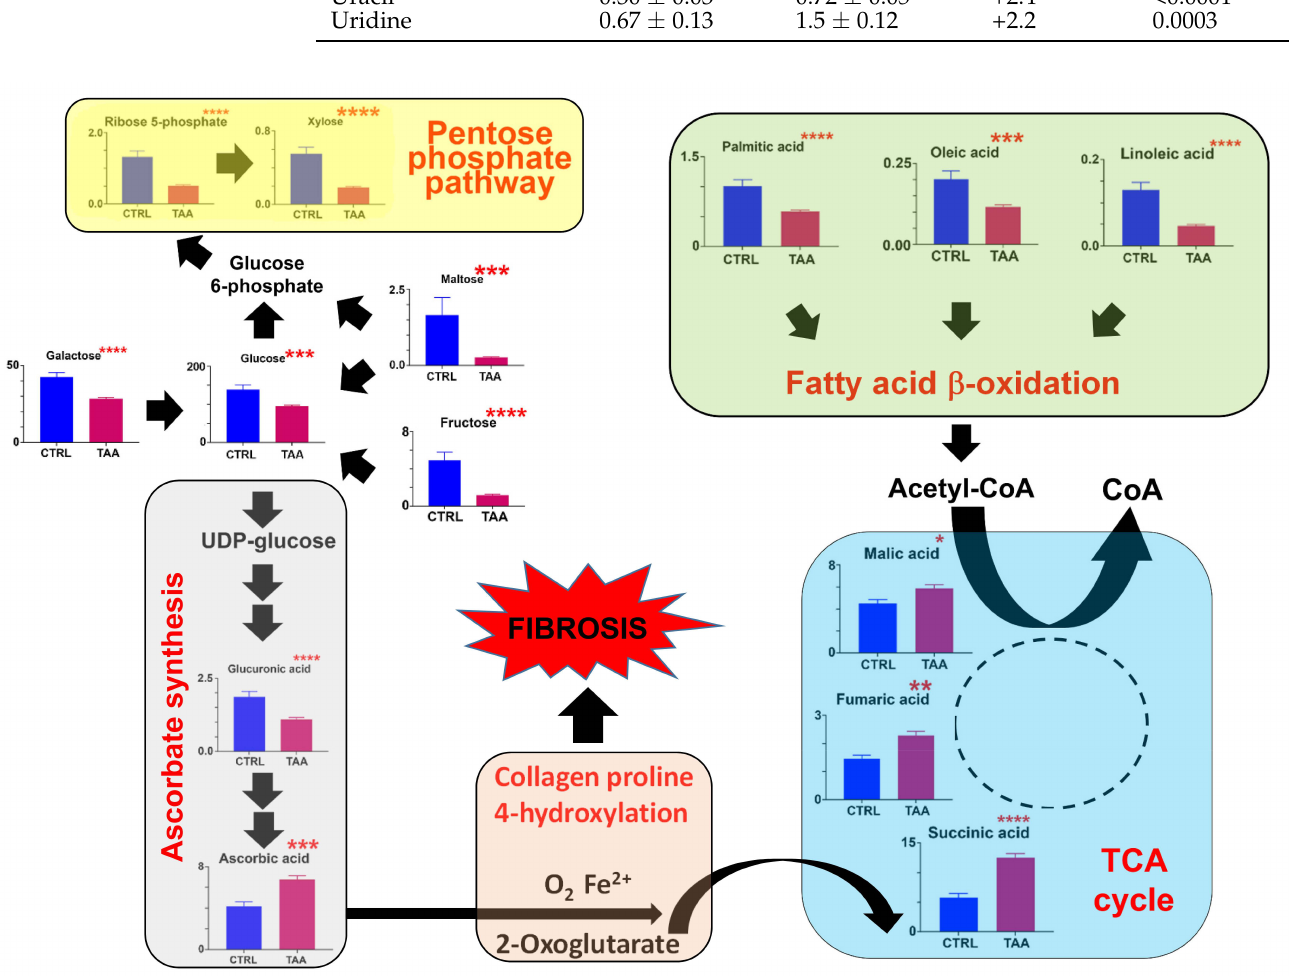
Figure 4. The appropriation of glucose metabolism for ascorbate synthesis in the livers of mice administered thioacetamide * = p < 0.05; ** = p < 0.01; *** = p < 0.001; **** = p <